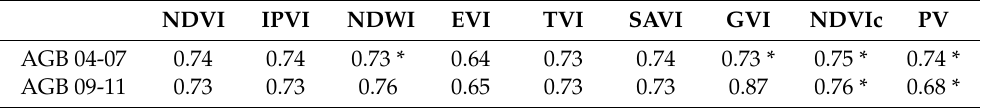
Table 3. Pearson correlation coefficients (r) from vegetation indices and Biomass (AGB).